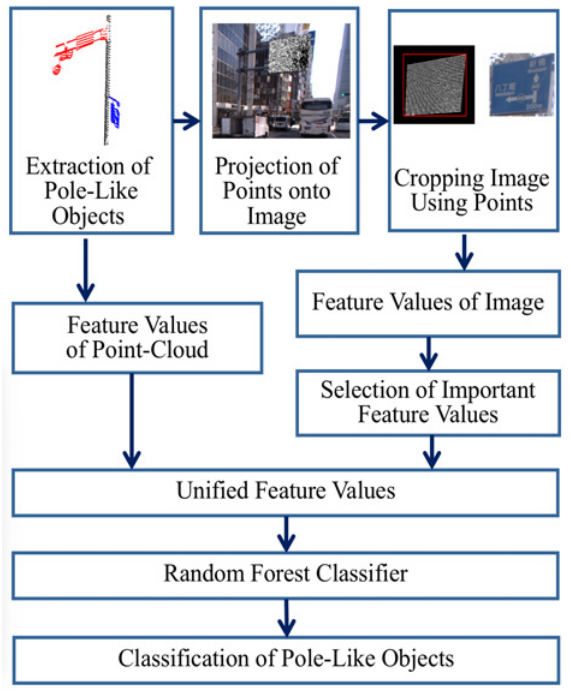
Figure 5. Process of object classification